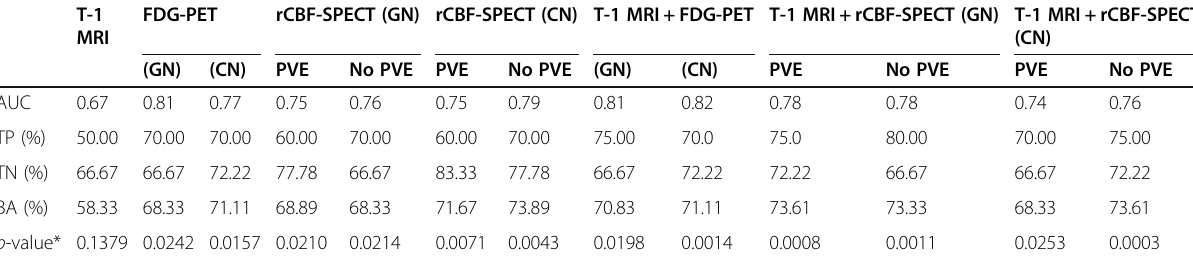
Table 4 Classification accuracy for individual and combined image modalities T-1 MRI